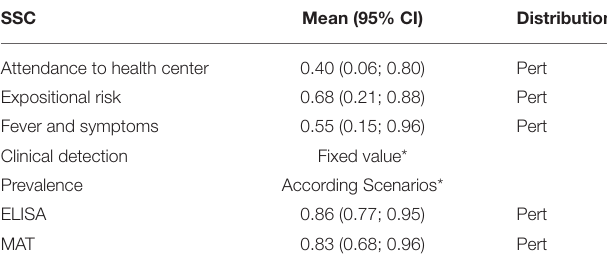
to identify possible outbreaks and to trace other contacts. TABLE 3 | Mean probability and their 95% confidence interval of the surveillance system component (SSC) inputs of the current surveillance system for